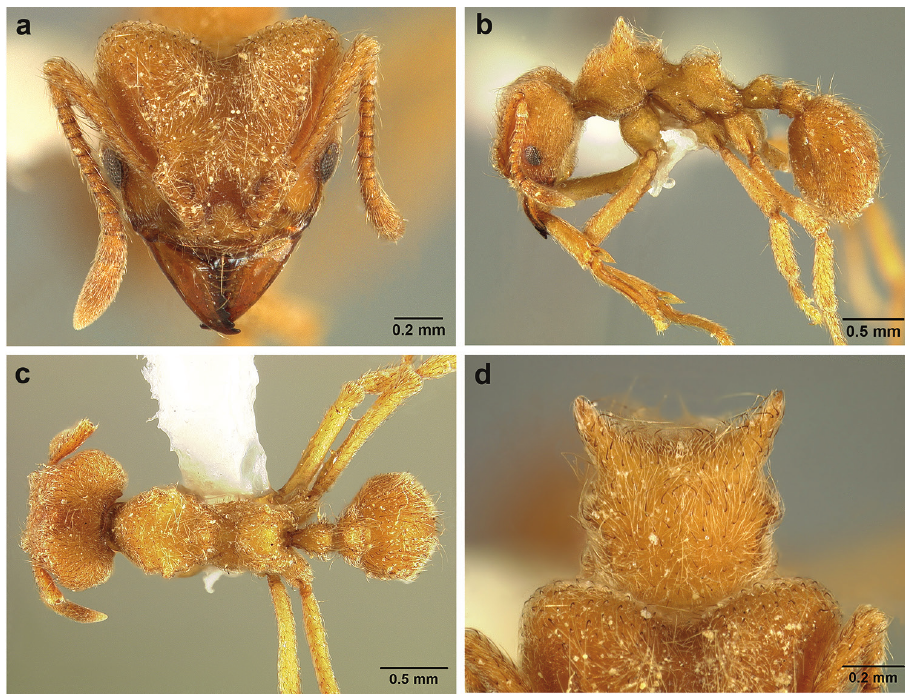
Figure 51. S. radioheadi worker (USNMENT00924059). a Head b lateral profile c dorsal view; and d frontodorsal view of mesonotal tubercles.